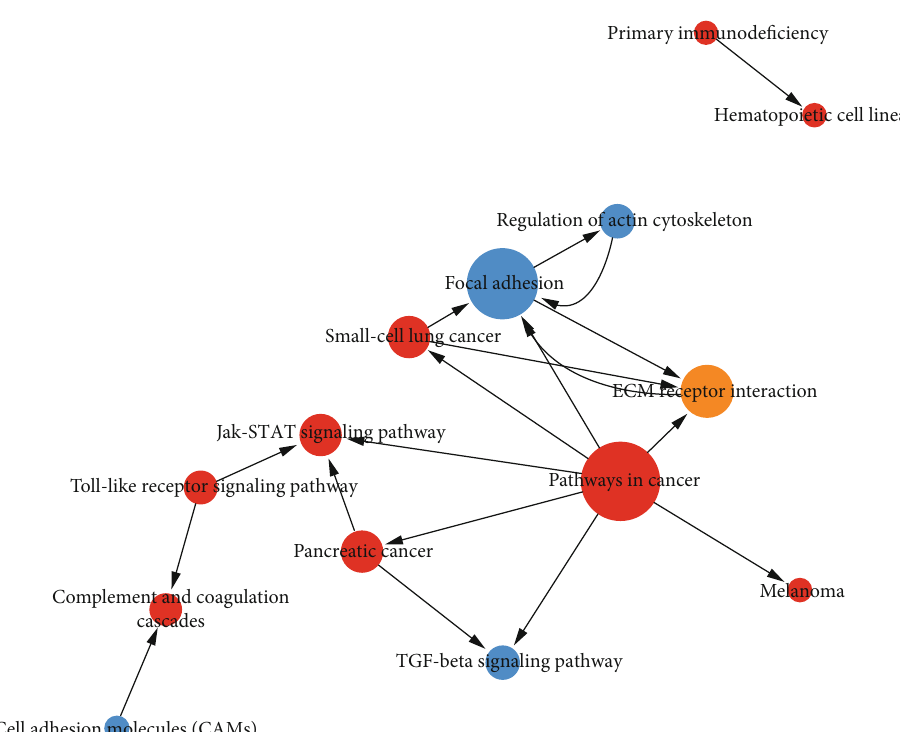
Figure 5: Analysis of the interaction network of signi fi cant pathways (Path-net) in the KDM3B overexpression group compared with the control group. A pathway of a high degree means that it played an essential role in the signaling network. Red indicates upregulated pathways, blue indicates downregulated pathways, and yellow indicates up- and downregulated pathways. Circle nodes represent a pathway, and the lines indicate the interactions between two pathways.